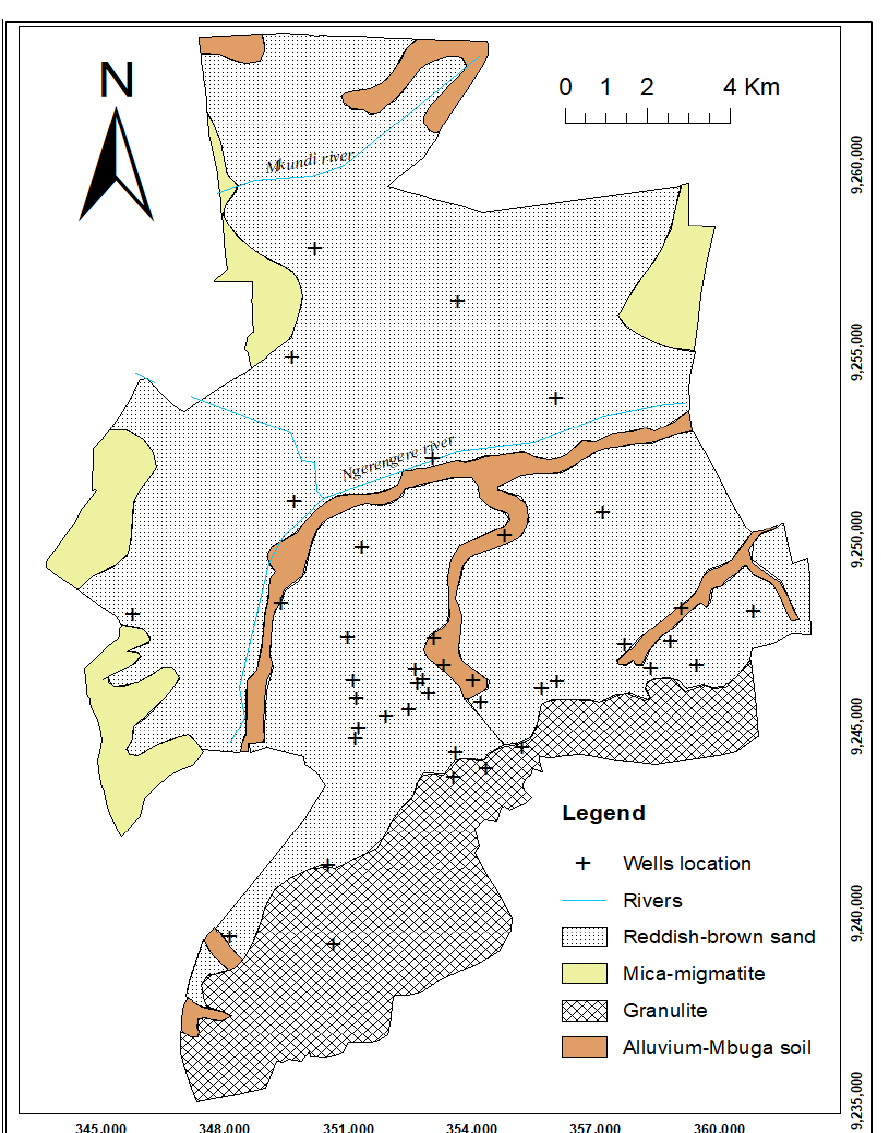
Figure 3. Hydrogeological map of the study area.